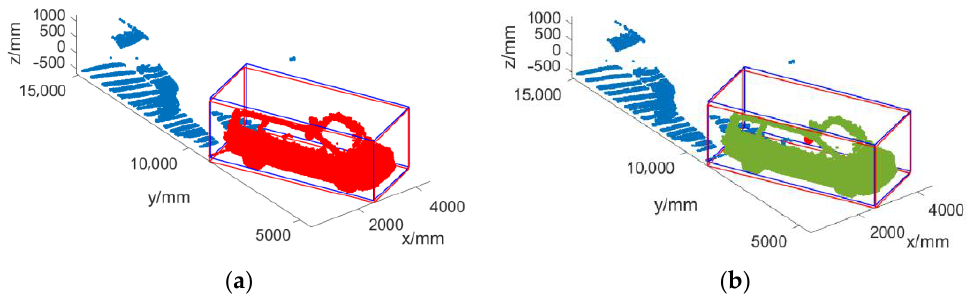
Figure 34. Comparison between the ANFIS method and Frustum-Pointnet [24], where the blue box is the ground truth, and the red box is the estimated results: ( a ) with outlier exclusion by ANFIS; ( b ) with the segmentation by Frustum-Pointnet. Table 13. Localization error of the cars.